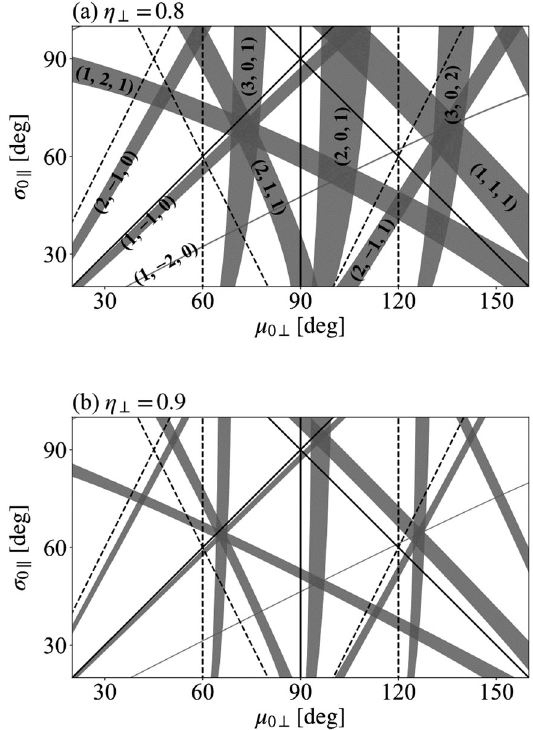
FIG. 8. Stability tune diagram obtained from the coherent resonance condition in Eq. (4) and the bandwidth formula in Eq. (A1). The coherent core instabilities of the second-order or third-order modes could be excited in gray shaded areas. The number of particles in a bunch is fixed everywhere at the value that corresponds to the two cases where (a) η ⊥ ¼ 0 . 8 and (b) η ⊥ ¼ 0 . 9 at the operating point ð μ 0 ⊥ ; σ 0 k Þ ¼ ð 50 . 0 ° ; 26 . 4 ° Þ . The bunch is assumed to be equipartitioned at this initial ionization point. Three numbers in the bracket written on each instability band represent ð n ⊥ ; n k ; n 0 Þ in Eq. (4) used to draw the band. The same solid and dashed lines as indicated in Figs. 6 and 7 are replotted for